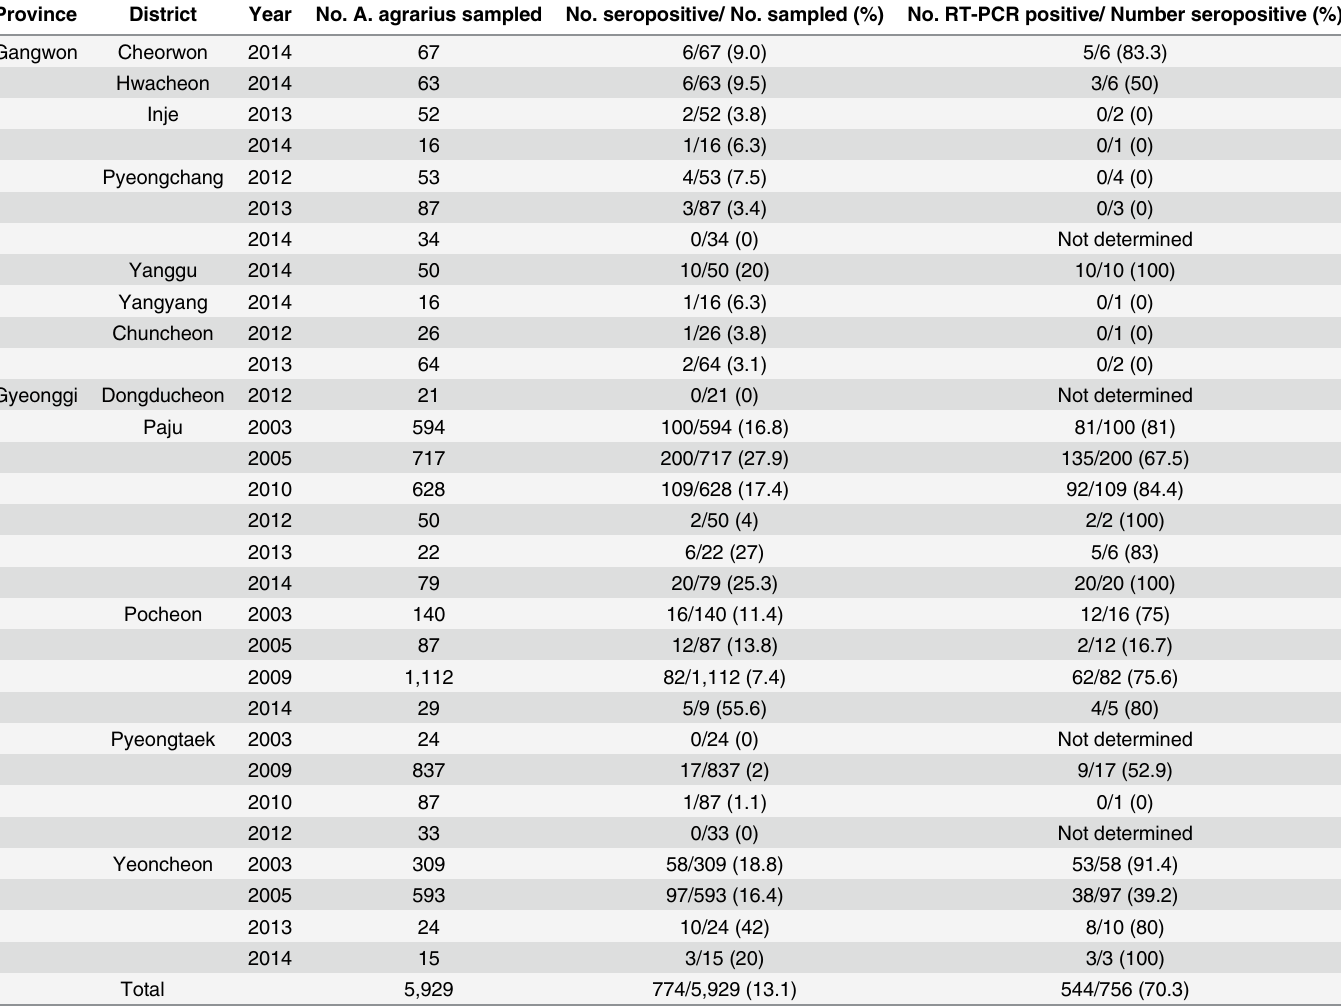
Table 1. Total number and screening results of A . agrarius collected from Gyeonggi and Gangwon provinces in the Republic of Korea, 2003 – 2014. Province